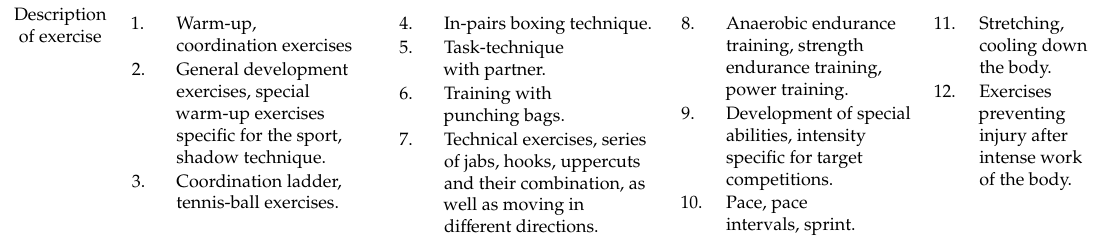
Table 1. Description of exercises performed during the afternoon training session (60 min) in the experimental (hypoxia) and control (normoxia) groups.